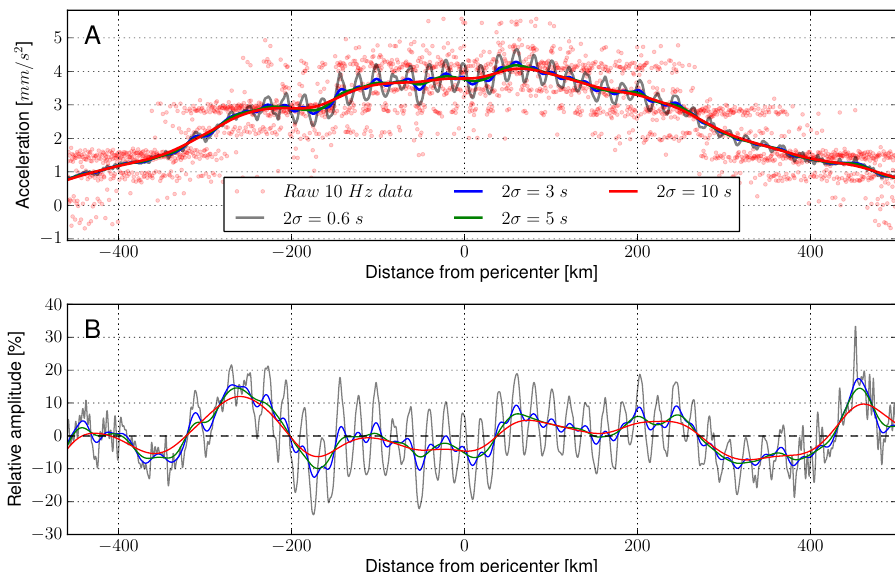
Figure 3. ( A ) Semi-raw and filtered acceleration and ( B ) its relative perturbations with respect to the seventh-order polynomial fit during pass number 446, as the functions of the distance from the pericenter using filters of different widths: semi-raw 10 Hz acceleration data (red symbols); semi-raw data smoothed with a Gaussian filter of 2 σ = 0.6 s (black), 2 σ = 3 s (blue), 2 σ = 5 s (green), and 2 σ = 10 s (red).